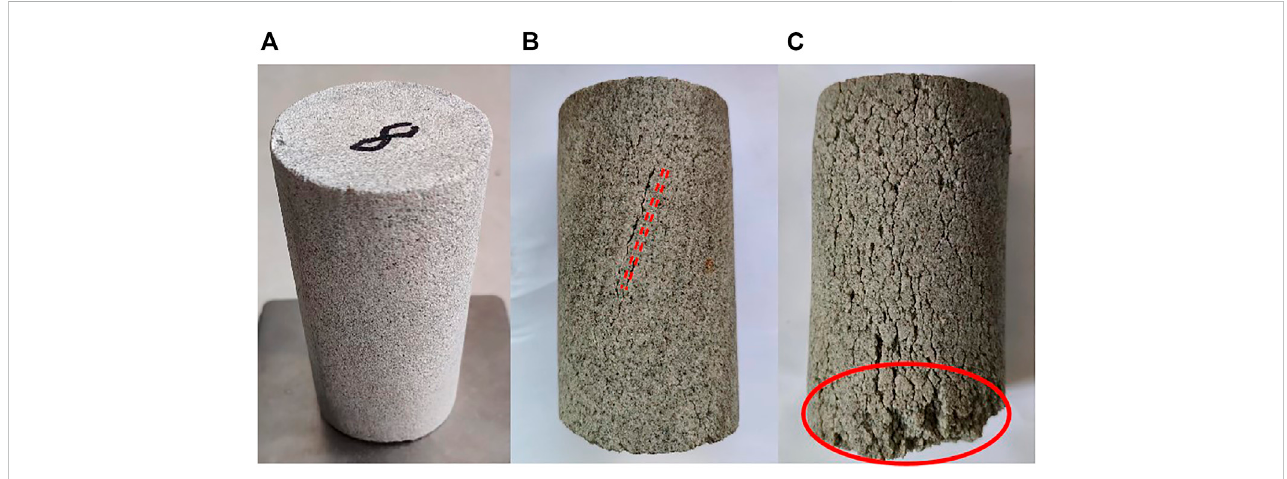
FIGURE 5 Microstructure of specimens before and after freeze-thaw times. [ (A) 0 freeze-thaw time; (B) 40 freeze-thaw times].